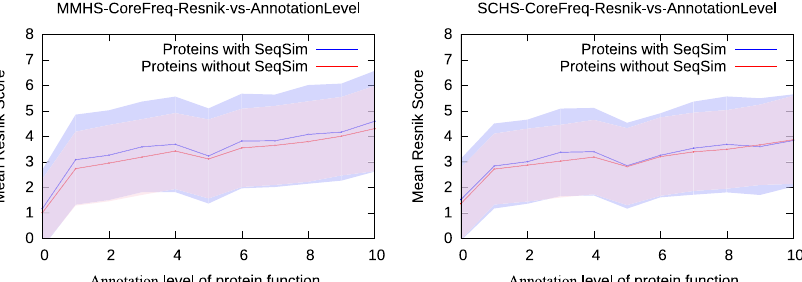
Fig. 3 Protein pairs aligned by network topology alone have equal Resnik similarity — not including sequence-based evidence — independent of whether they possess sequence similarity. Note the horizontal axis here is no longer NAF, it is annotation level of aligned pairs across all those with NAF 2% or higher. We plot mean Resnik score as a function of annotation level for MMHS (left) and SCHS (right). In each plot, aligned protein pairs ( p , q ) are binned along the horizontal axis into the integer part of the NetGO-based annotation detail 111 of the lesser understood protein. The vertical axis is mean Resnik score, with shading out to 1 σ standard deviation of the pairs in that bin. Blue is protein pairs with sequence similarity, red is those without. In all cases, the Pearson correlations are above 0.35 and have p -values below 10 − 300 before binning to take the mean, while the p -value of Pearson correlation of the binned means are about 2 × 10 − 3 ; the difference between the means has p -value above 0.4 — i.e., far from statistical signi fi cance. The Resnik scores here are signi fi cantly lower than those in Fig. 2 for two reasons: fi rst, we have, of necessity, removed all sequence-based evidence, and second, the mean is dominated by the high number of low-NAF (NAF = 2%)